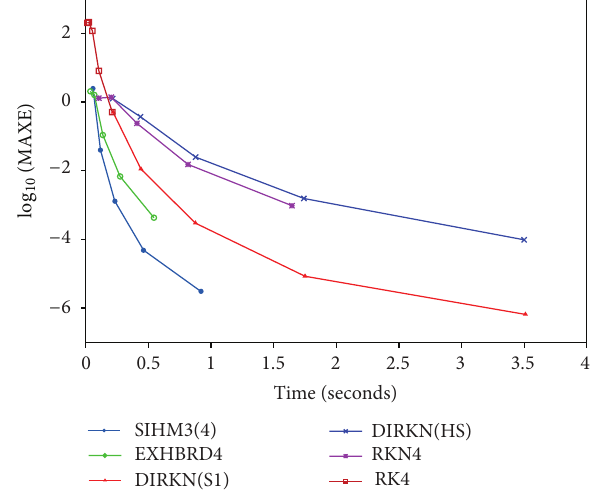
Figure 8: The efficiency curves for SIHM3 (5) and SIHM4 (5) methods for Orbital problem with ℎ = 0.125/2 𝑖 , 𝑖 = 4,...,8